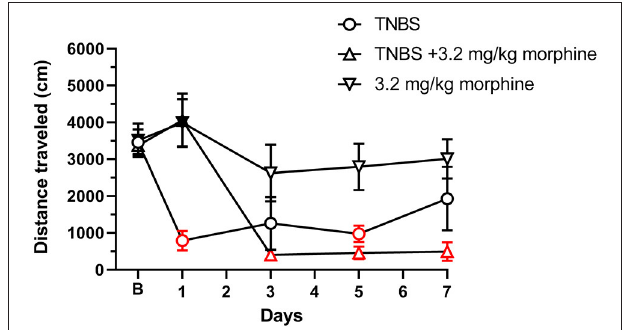
FIGURE 12 | Daily administration of 3.2 mg/kg morphine exacerbates TNBS-induced depression of locomotor activity. Distance traveled (in cm) at 30min recorded at baseline (denoted by “B”) and every alternate day for 7 days in mice treated with TNBS and/or 3.2 mg/kg/day morphine. Locomotor activity was measured 30min after morphine injection. TNBS, but not morphine alone, significantly reduced locomotor activity that recovered to baseline on Day 7. Morphine on Day 1 only prevented the TNBS-induced depression of locomotor activity, however, repeated morphine treatment exacerbated TNBS-induced decrease in locomotion and prevented recovery to baseline. Data are mean ± SEM. TNBS ( N = 6/day); 3.2 mg/kg morphine ( N = 6/day); TNBS + 3.2 mg/kg morphine ( N = 6 for Days 1, 3, and 5, and N = 4 for Day 7). N = 6/group for baseline. Red points indicate significance ( P < 0.05) vs. B indicated by a significant time x treatment interaction by repeated measures two-way ANOVA with Dunnett’s test. Filled points indicate significance vs. TNBS by Bonferroni’s post-hoc